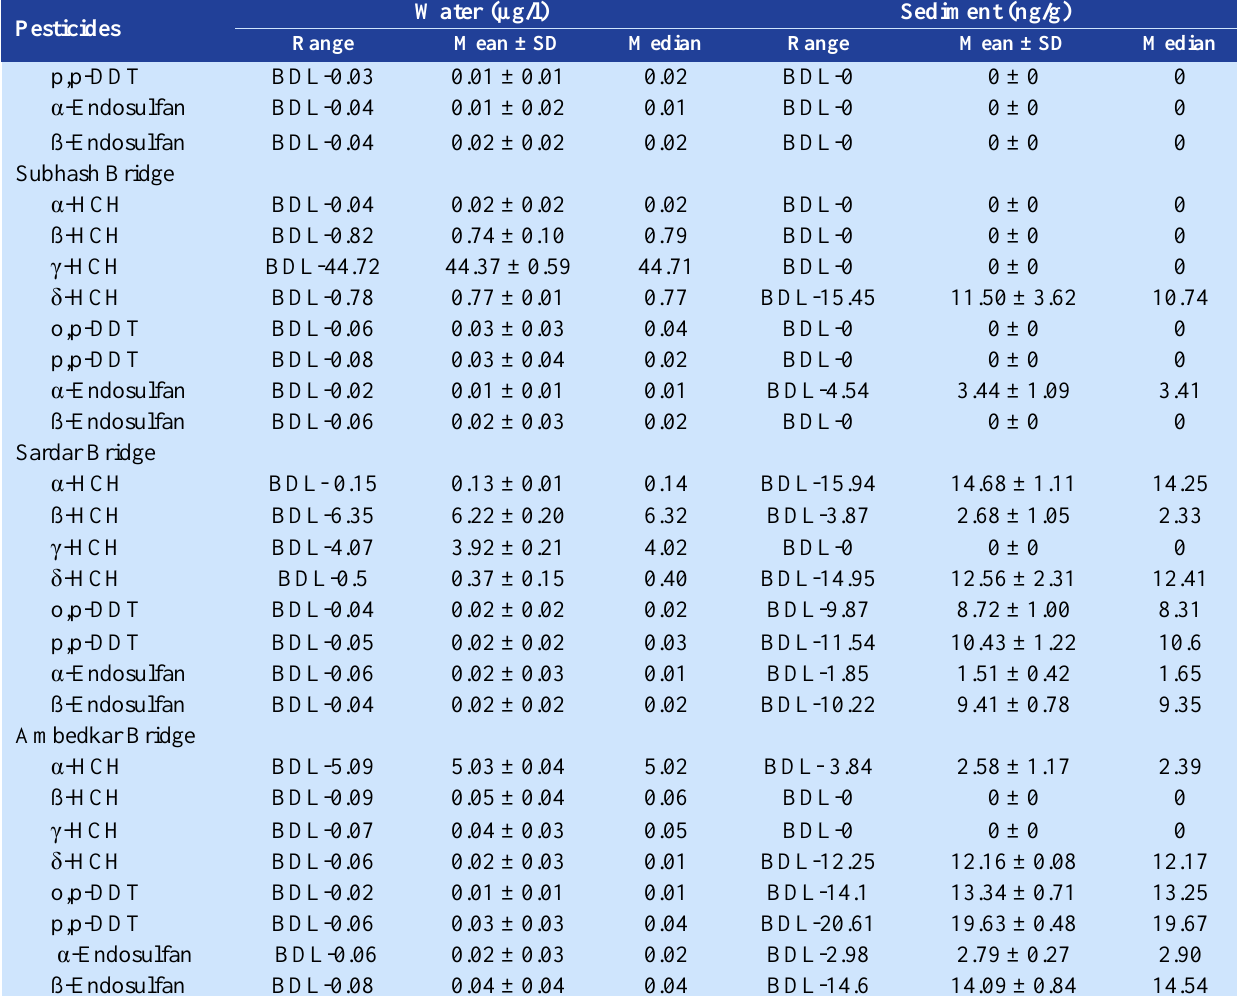
Table 2. Basic statistics of organochlorine pesticides (OCP) residues in water and sediment samples of the Sabarmati River